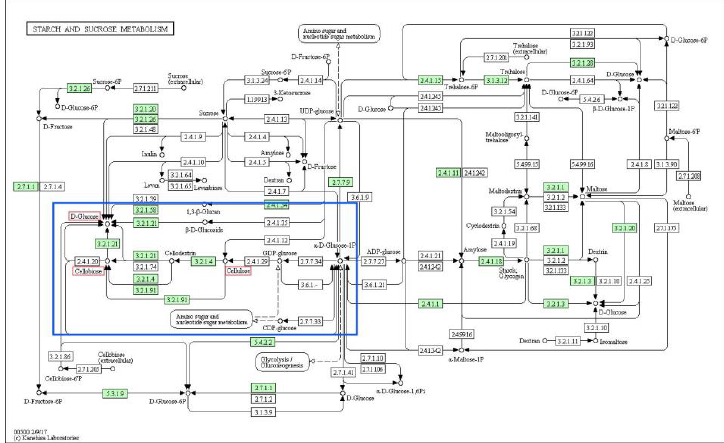
Figure 2. The cellulose degradation pathway of A. heimuer . The red and green boxes indicate the substrates and existing homologous genes of the enzyme, respectively. The white boxes mean the enzymes that were not identified in A.heimuer genome. The blue box indicates the core region of the function. The figure was generated by a KEGG mapper. J. Fungi 2020 , 6 , x FOR PEER REVIEW